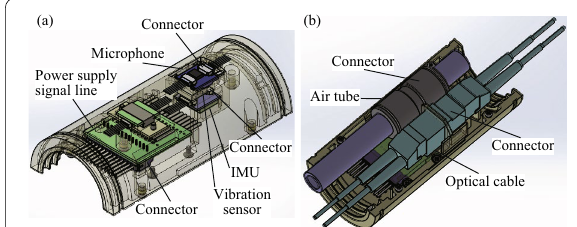
Fig. 5 CAD diagram and photo of the connecting module. a Configuration of the sensor fixing part and the power supply connector of the module connection part. b Configuration of the connectors of the optical cable and air tube in the module connection section. 180-degree rotation of ( a )